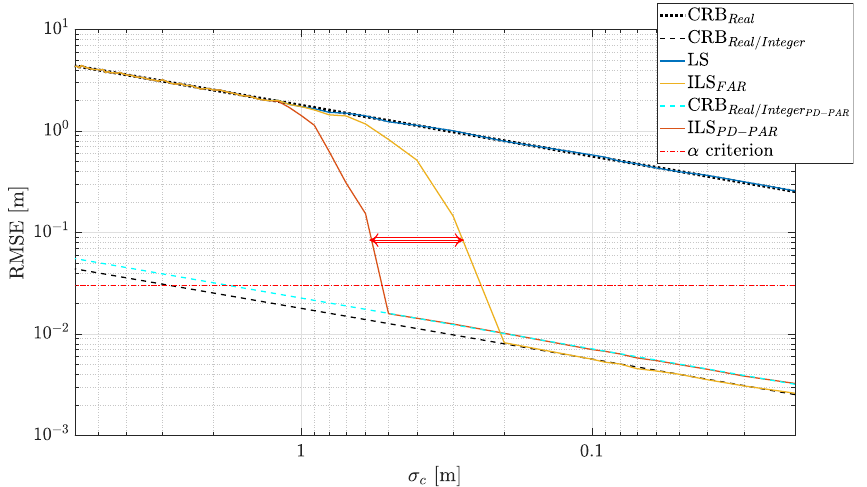
Figure 2. RMSE and CRB as a function of the code noise standard deviation, σ c , for FAR and PD-PAR schemes illustrating the difference between both asymptotic